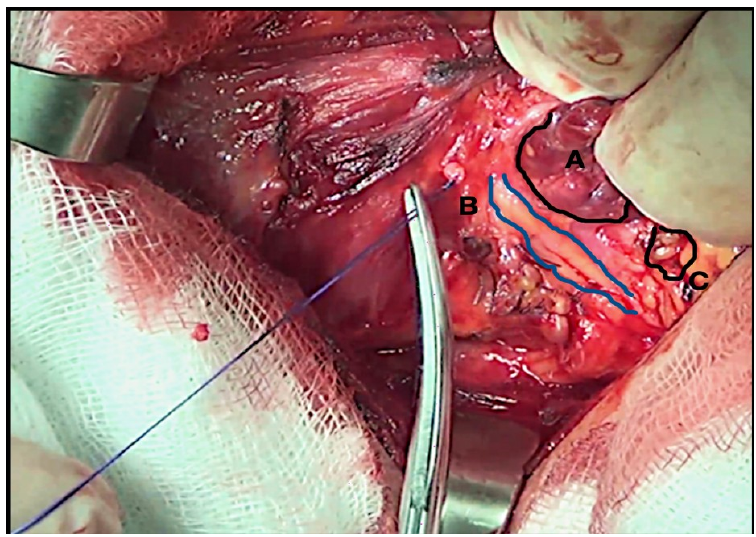
Figure 3. RLN dissection with optical magnification 2.5 × . A Thyroid gland. B Right-sided RLN identified and isolated. C Inferior parathyroid gland.